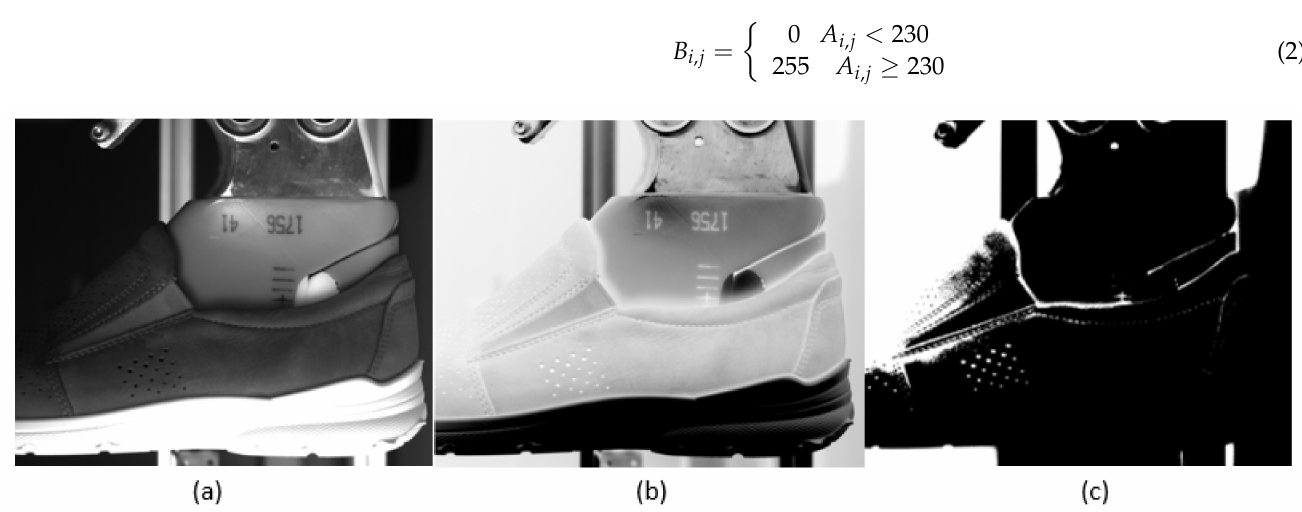
Figure 4. Illustration of original picture ( a ), inverted picture ( b ) and highlight shadows ( c ).